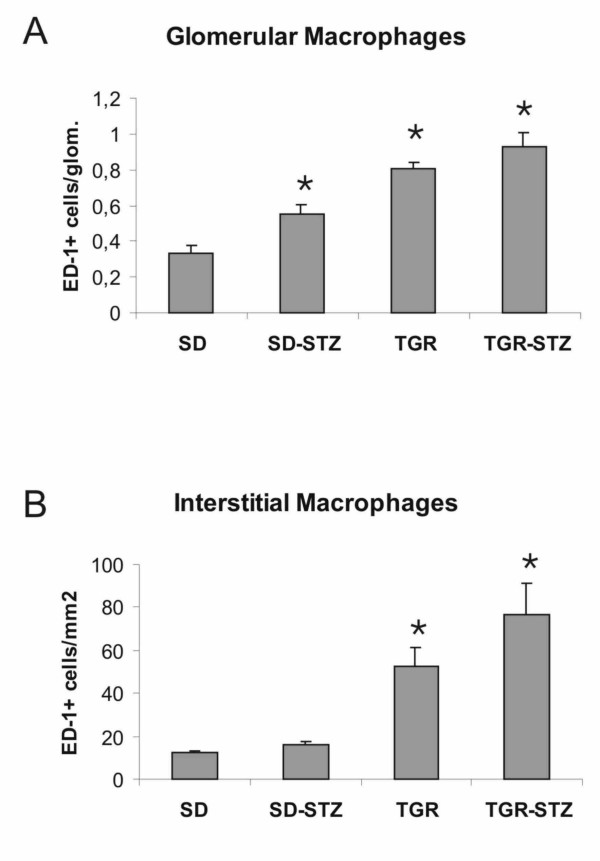
Macrophage infiltration of glomeruli (panel A) and interstitial space (panel B) of the kidney from rats with diabetes mellitus and/or hypertension. Glomerular macrophages are expressed as ED-1-positive cells per glomerular cross-section, interstitial macrophages as ED-1-positive cells per square mm. SD, normotensive normoglycemic control rats; TGR, transgenic hypertensive rats; STZ, streptozotocin treatment. Data are mean ± SEM of n = 5 rats. * indicates p < 0.05 versus normotensive normoglycemic SD control rats.